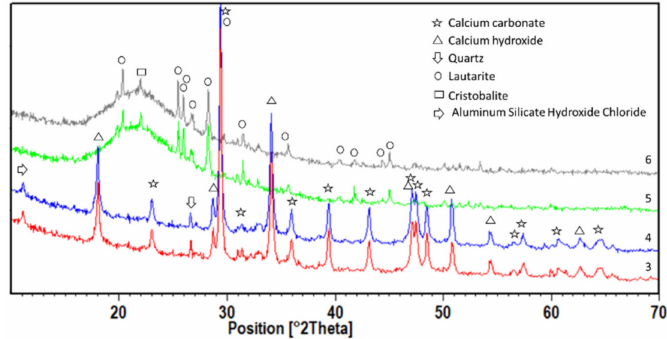
Figure 3. XRD patterns of samples 3, 4, 5 and